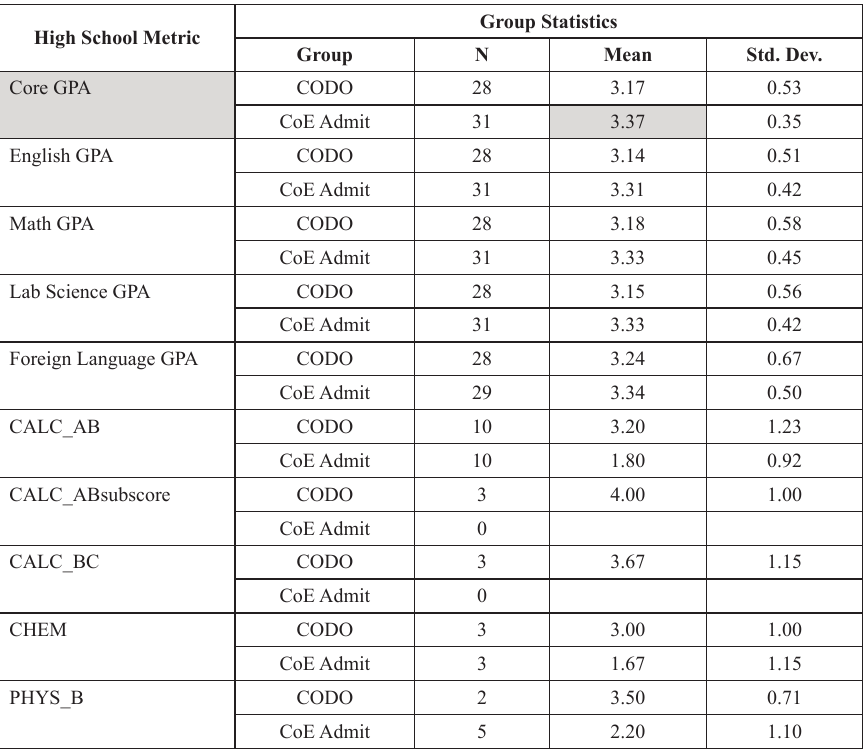
Table 5. Group statistics of High School Incoming Metrics compared between Change of Degree Objective (CODO) Graduates in the Purdue College of Engineering (CoE) against Purdue Engineering Direct-Admit students who didn’t graduate in any major Group Statistics High School Metric Group